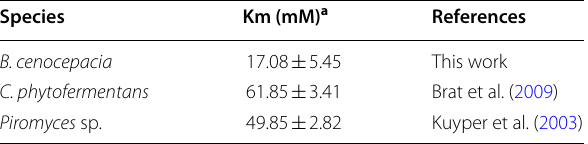
a K m values were obtained for d -xylose and are expressed with standard error calculated from a duplicate of independent assays